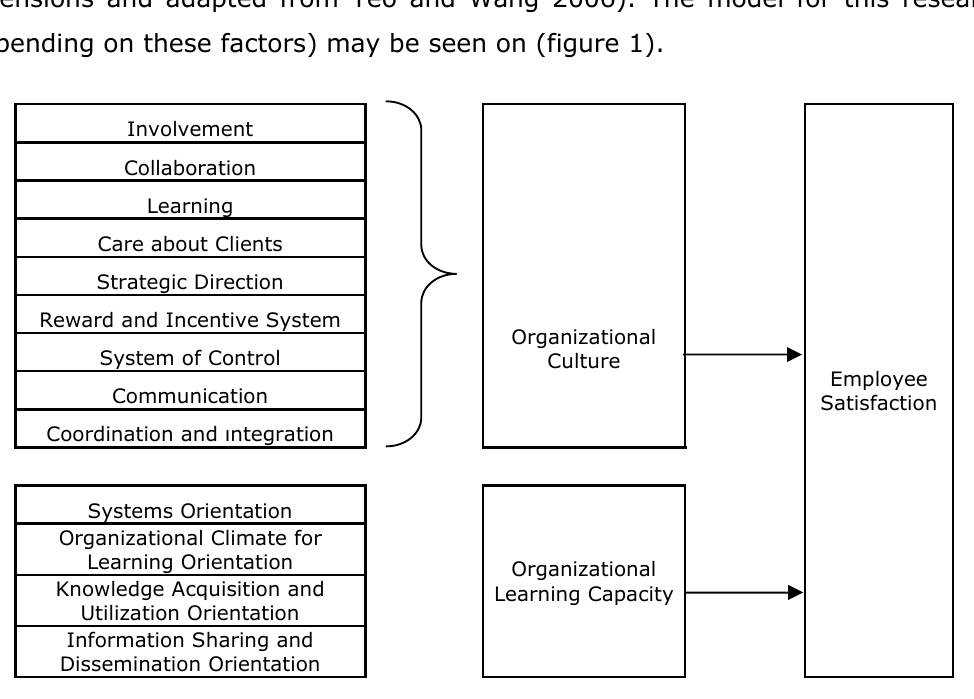
Figure 1. “The model of the